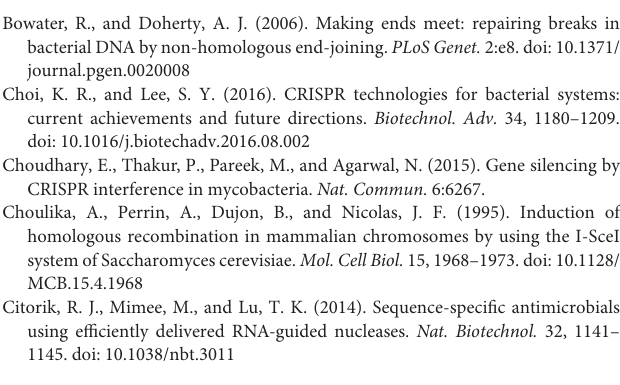
Supplementary Figure 1 | Protein modeling of wild-type and in-frame mutants of L. biflexa β -galactosidase. Wild-type, WT (A) and mutant clone “d” (B) , which had a 3-bp deletion resulting in the loss of a valine residue (shown in orange in the WT), are shown separately. Both structures were superimposed (C) and subtle changes in β -sheets could be seen close to the deletion site (D)